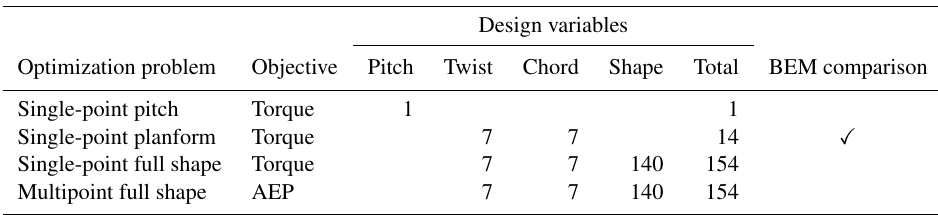
Table 5. Overview of optimization problems.